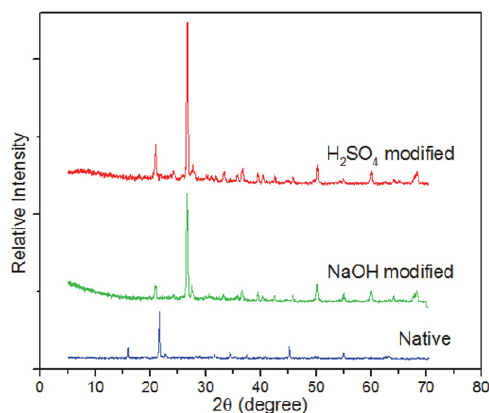
Figure 3. XRD of the native and chemically modified brick kiln slag